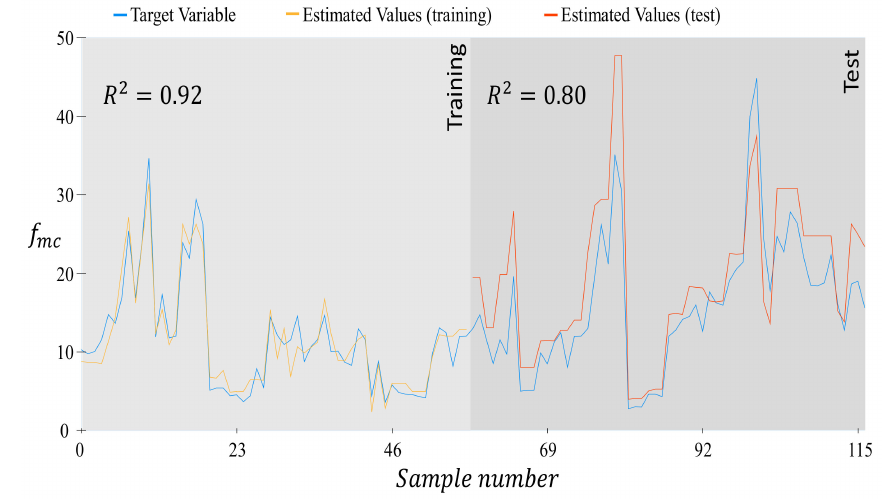
Figure 6. Prediction quality of the symbolic regression based black-box model. Statistical indictors for both training and test data are presented in Table 4. An error analysis is carried out to evaluate the model quality. The coefficient of determination Equation (10), average relative error Equation (11), the mean absolute error Equation (12), mean squared error Equation (13), and root mean squared error Equation (14) are